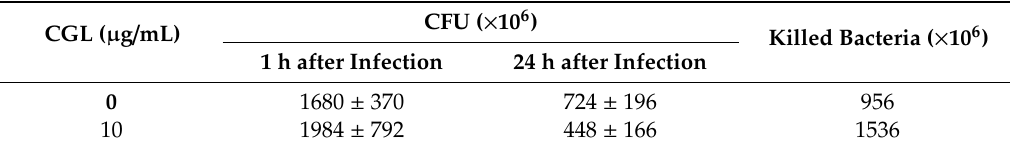
Table 5. Influence of CGL on RAW264.7 macrophage bactericidal activity (values were calculated using data from